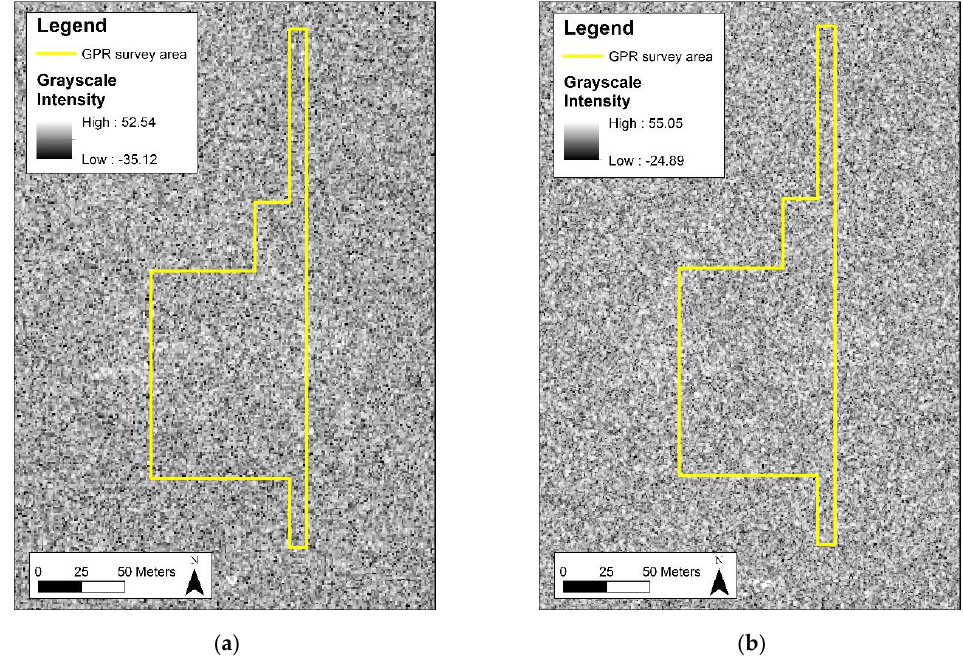
Figure 6. TanDEM-X bistatic grayscale intensity images (dB) with black representing low intensity values and white representing high intensity values. ( a ) 13 May 2017 VV image. ( b ) 15 April 2017 HV image.